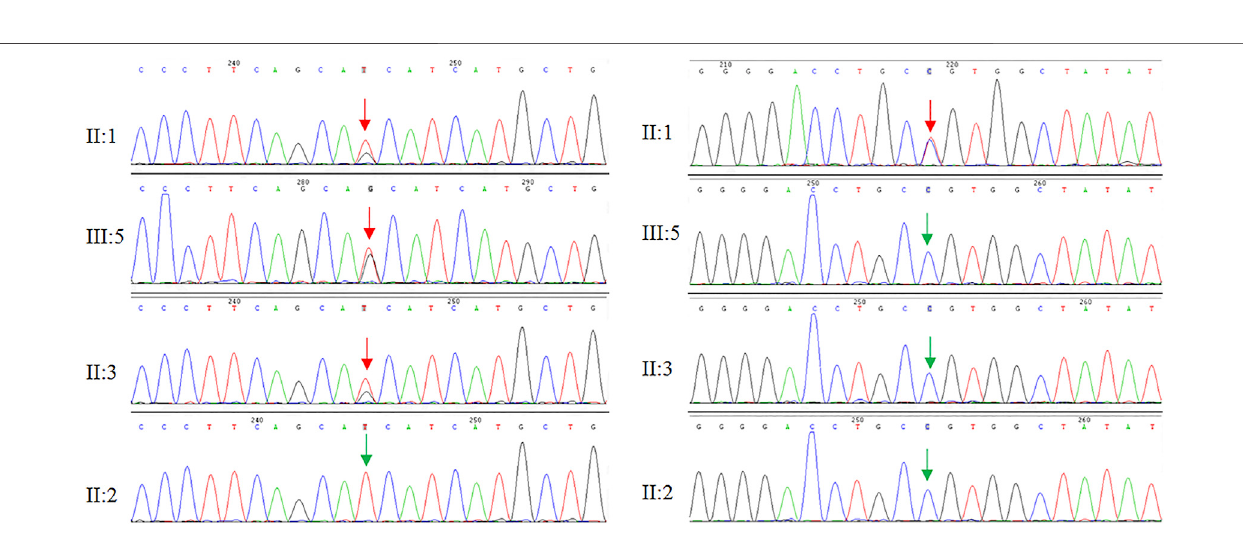
FIGURE 3 | Genome sequencing revealed two heterozygous mutations in the DAB1 and NOTCH3 gene, respectively.